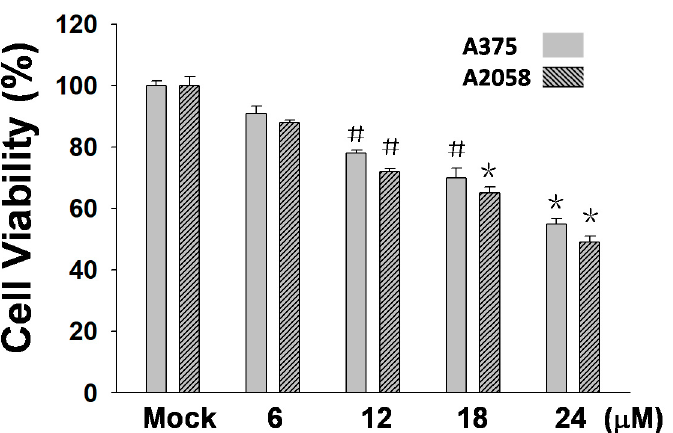
Figure 2. Results of an 3-(4,5-Dimethylthiazol-2-yl)-2,5- diphenyltetrazolium bromide (MTT) assay using varying concentrations of (+)-bornyl p -coumarate (0, 6, 12, 18, 24 µM). (+)-Bornyl p -coumarate inhibited melanocyte cancer cell proliferation in A375 and A2058 cells ( # p < 0.05; * p < 0.01). Mock: cells treated with vehicle control (DMSO).